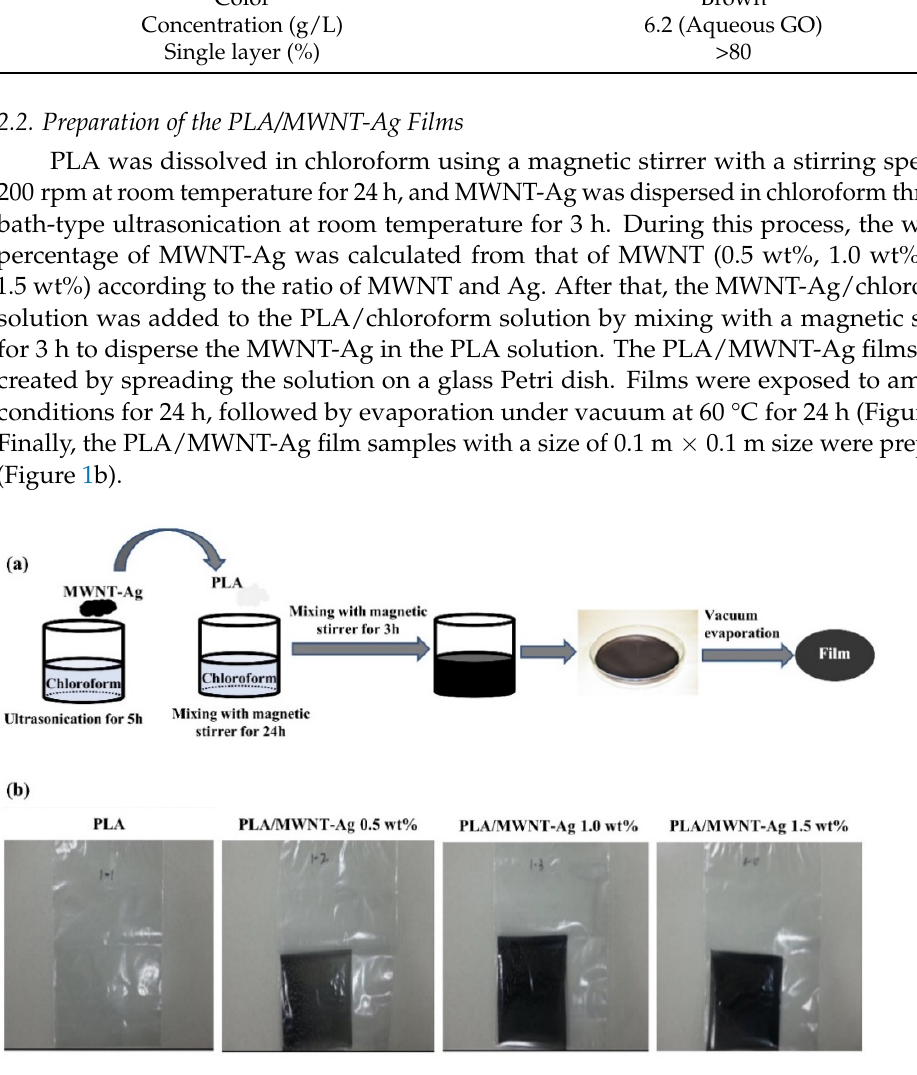
Figure 1. PLA/MWNT-Ag films prepared by solvent casting: ( a ) schematic illustration of the sample preparation; ( b ) PLA/MWNT-Ag film samples with different MWNT-Ag preparation; ( b ) PLA/MWNT-Ag film samples with different MWNT-Ag concentrations.